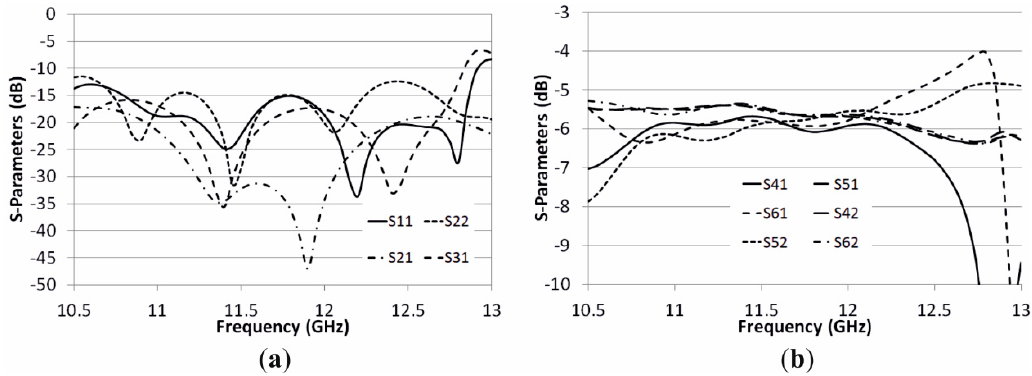
Figure 7. Photograph of the prototype of the six-port coupler. Figure adapted from [36].